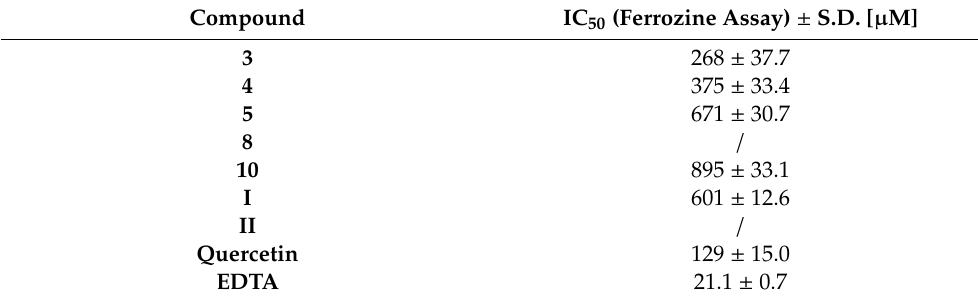
Table 1. Iron(II)-chelating properties of the synthesized compounds.